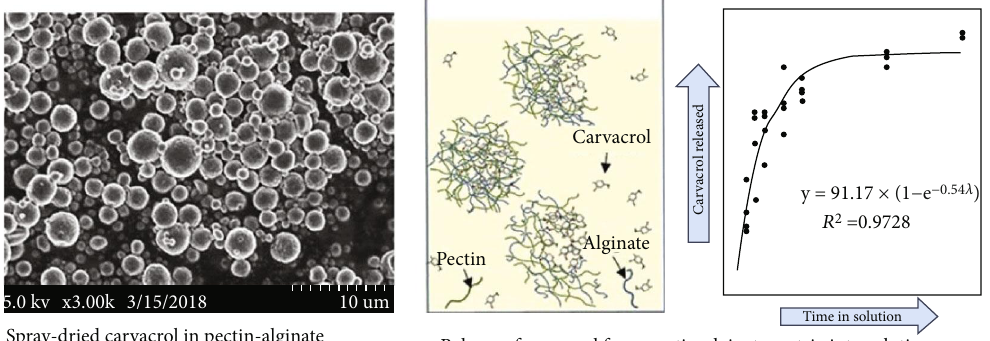
5.0 kv x3.00k 3/15/2018